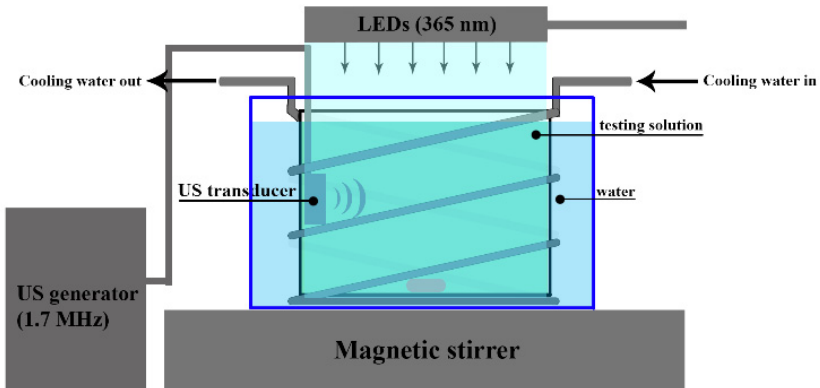
Figure 1. A scheme of sonophotoreactor.